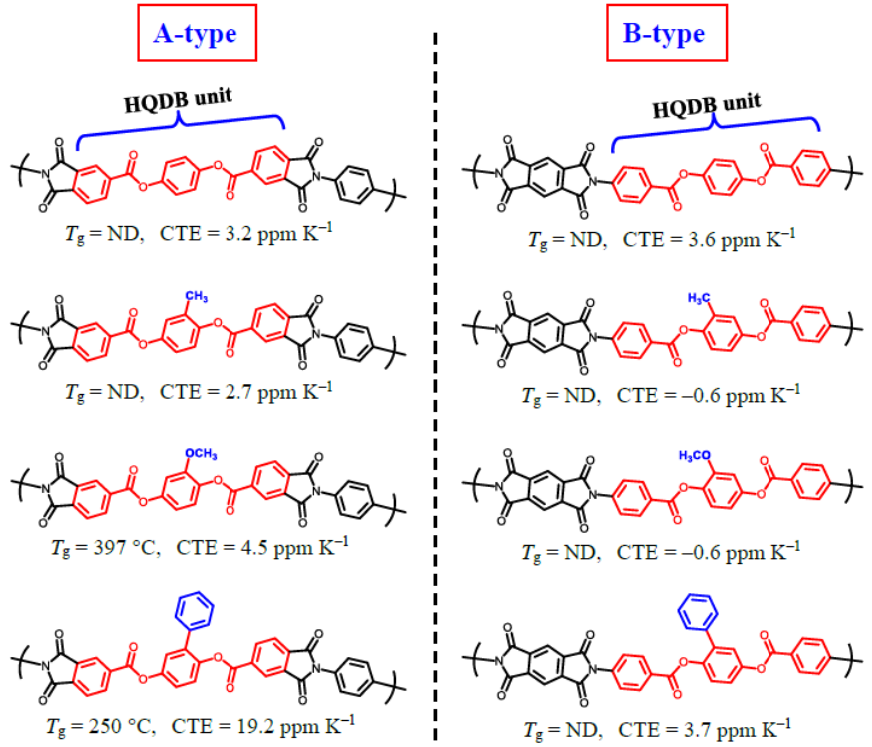
Figure 8. Comparisons of T g and CTE between the PEsIs (A-type) obtained from tetracarboxylic dianhydrides including hydroquinone dibenzoate (HQDB) unit (red-marked) with different substituents (blue-marked) and the PEsIs (B-type) obtained from HQDB-containing diamines.